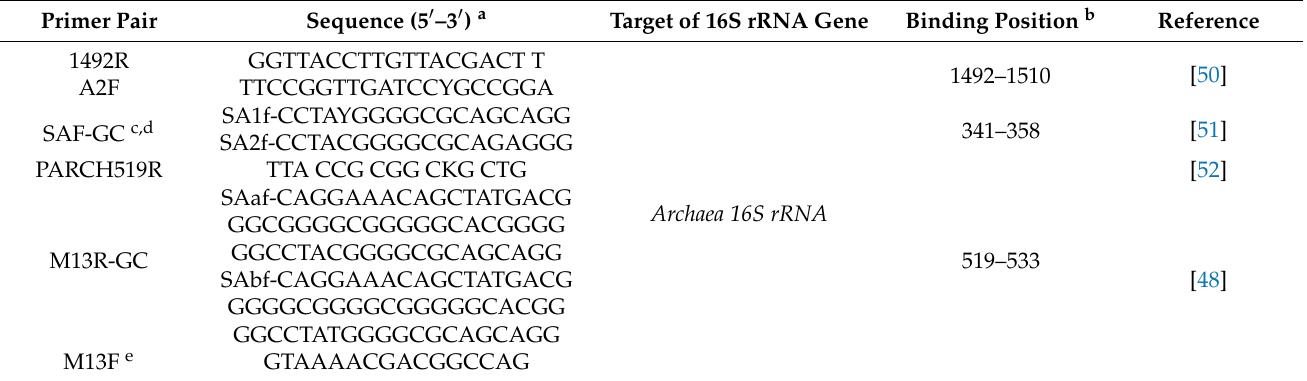
Table 1. PCR primers used in this